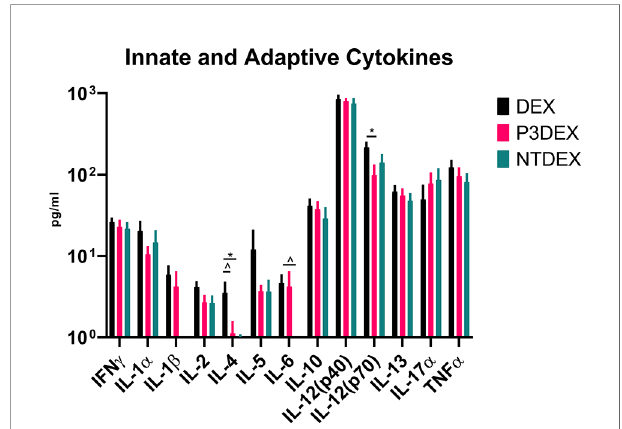
FIGURE 4 | LNFPIII and LNnT conjugates alter innate and adaptive cytokines. Measurement of innate and adaptive cytokines are shown here in response to DEX, P3DEX, or NTDEX treatment. One-way ANOVA with Dunnett ’ s Multiple Comparisons Test. *indicates a signi fi cant difference (p ≤ 0.05). ^indicates a trend (p ≤